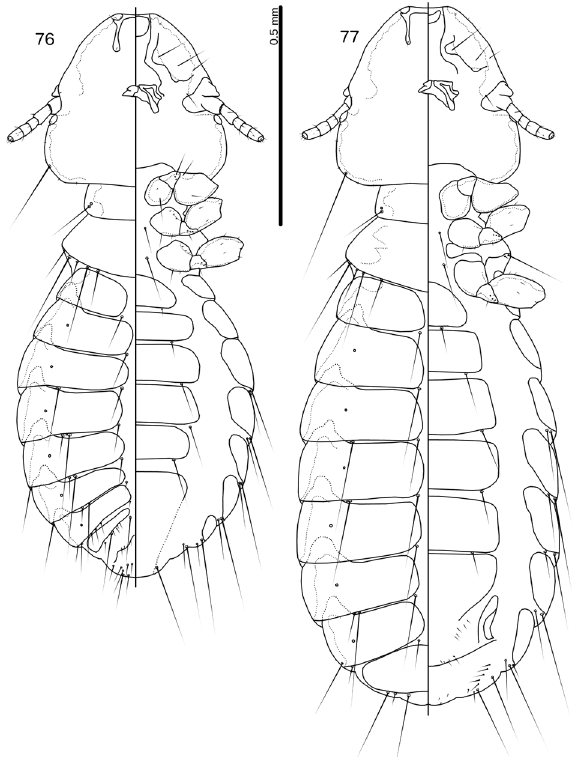
Figures 76, 77. Guimaraesiella haftorni (Balát, 1958) ex Tur- dus iliacus Linnaeus, 1758. 76 Male habitus, dorsal and ventral views 77 Female habitus, dorsal and ventral views.